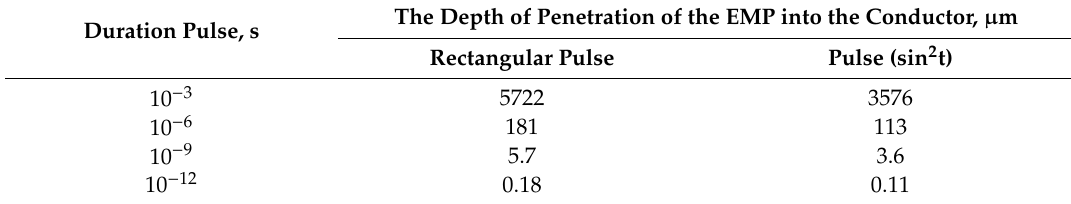
Table 2. Depth of electric field penetration into the